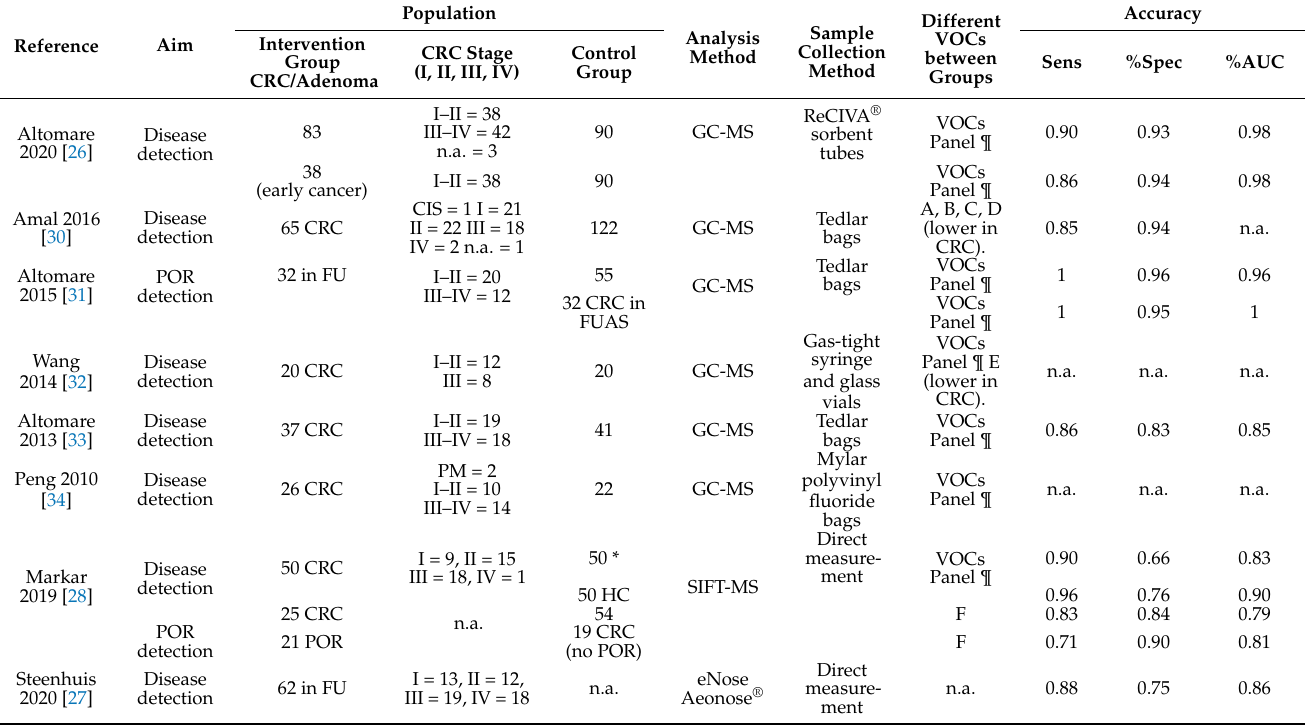
Table 2. Breath test VOCs and colorectal cancers or adenoma